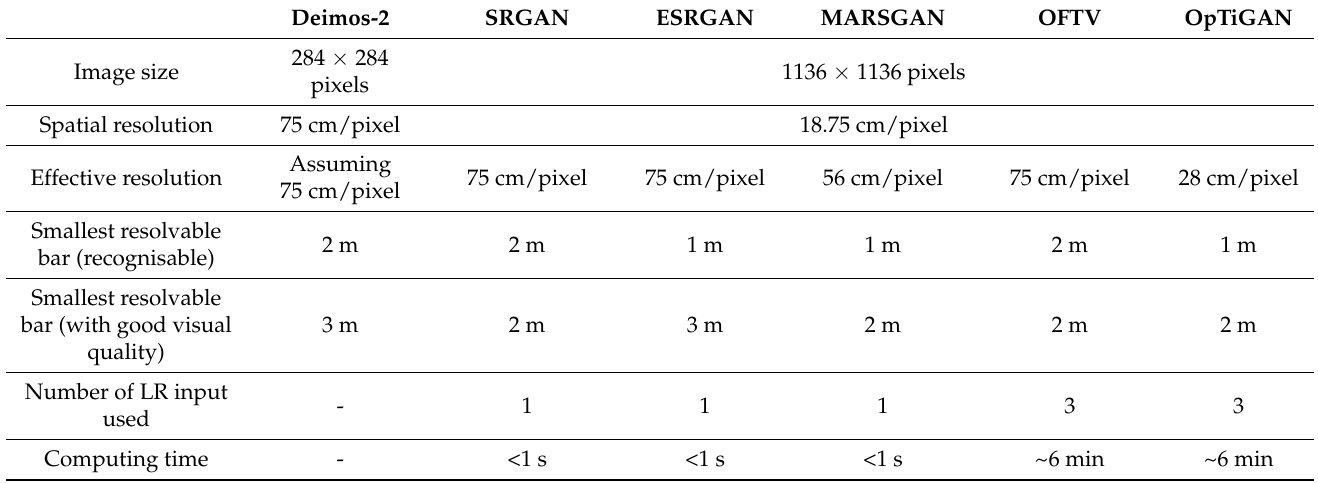
Table 7. Summary of the effective resolution derived from Figure 9 and Table 6, the smallest resolvable bar pattern targets observed from the Deimos-2 image and each of the SRR results, in comparison with Figure 5, as well as the number of input images used and computing time for the Baotou Geocal